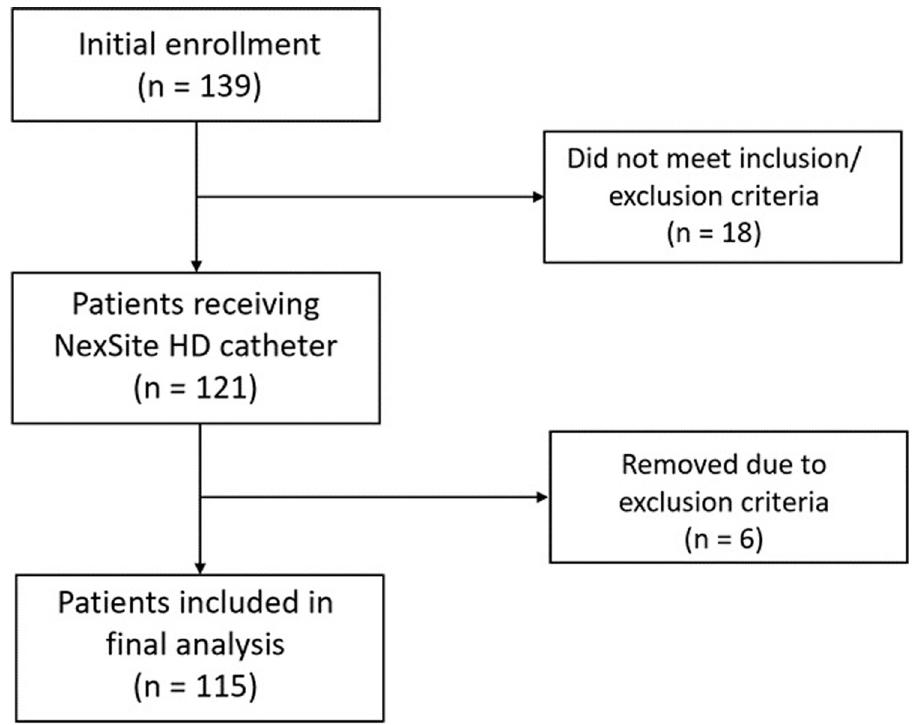
Fig 2. Disposition of patients enrolled in NextSite HD